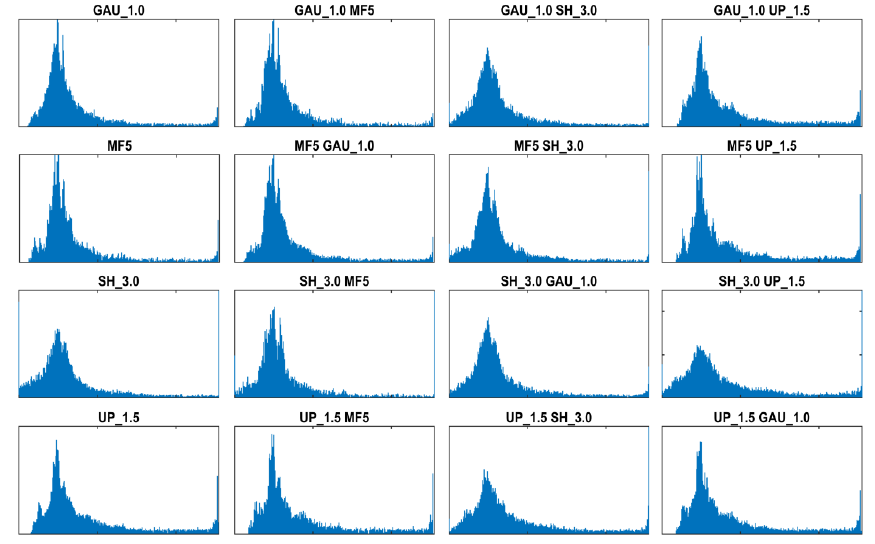
Figure 2. Image histogram for a single operator and dual operators.